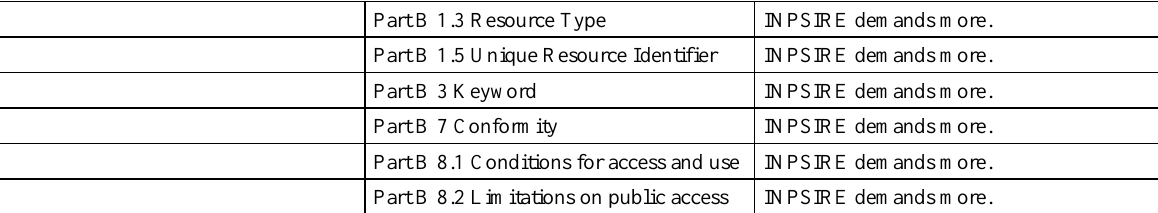
Table 1. INSPIRE metadata for spatial data